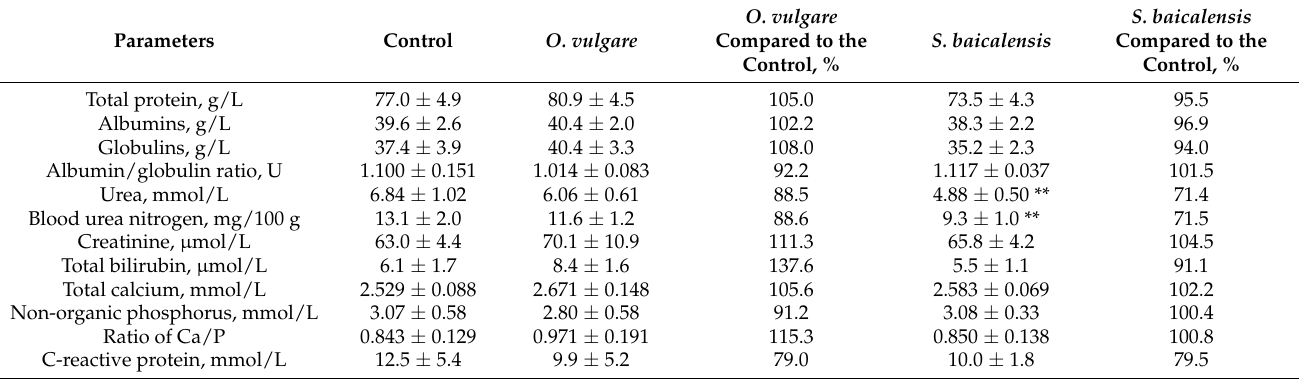
Table 4. Changes in the parameters of the protein and mineral metabolism in the blood of male rats under the effects of the addition of Origanum vulgare L. and Scutellaria baicalensis Georgi to their diet (x ± SD, n = 8, duration of experiment—30 days).